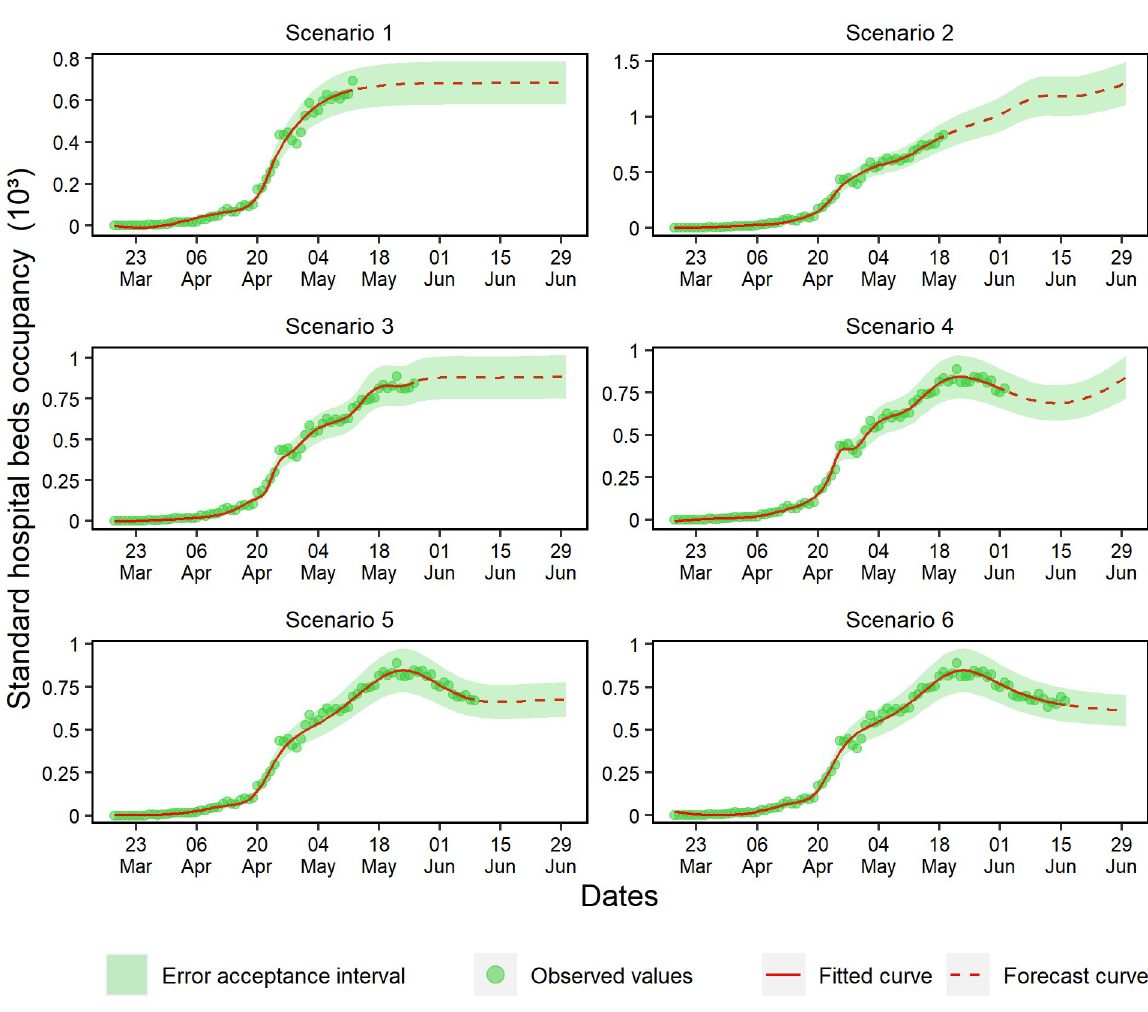
Fig 8. Forecasting of standard hospital beds occupancy in the six analyzed